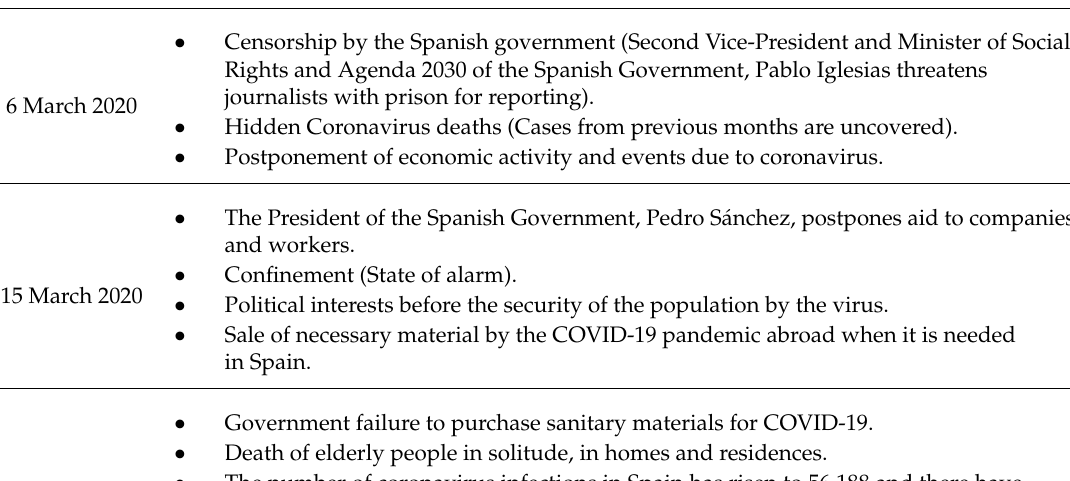
Table 4. Comments related to Sadness emotion and COVID-19 in digital ecosystems. Sadness Emotion Related to COVID-19 Comments in Digital